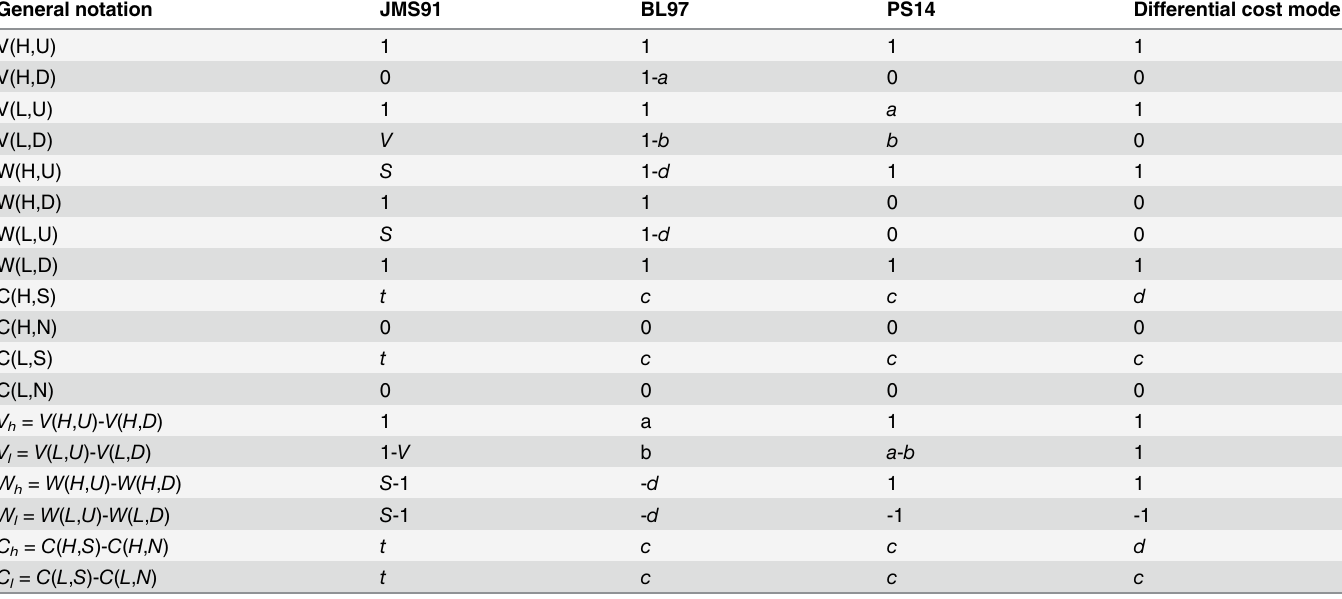
Table 3. Parametrization of the general model using three different action-response games [4,25, 26]. General notation